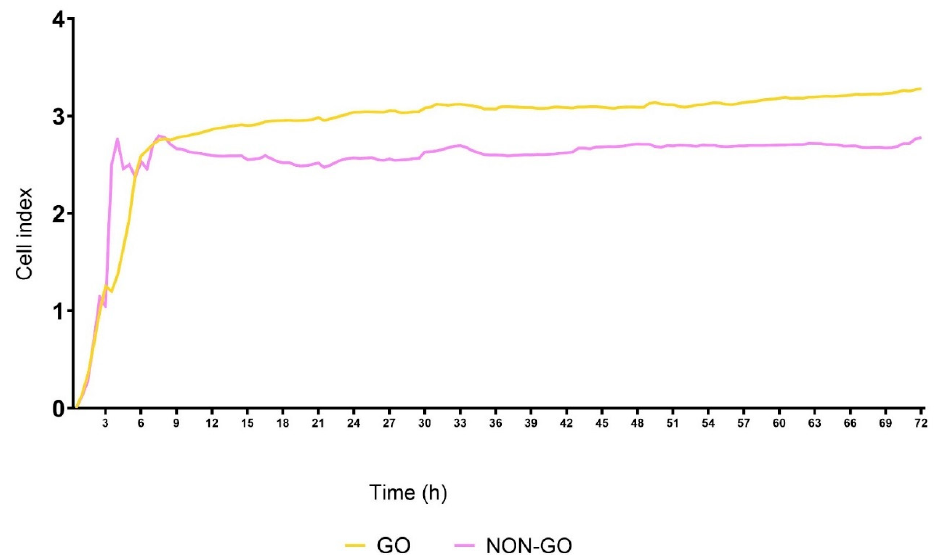
Figure 2. Comparison of the basal cell index values. The cell index of untreated GO cells was 3.3 and 2.79 of untreated NON-GO cells at the selected density (10,000 per well). All experiments were performed in triplicates.